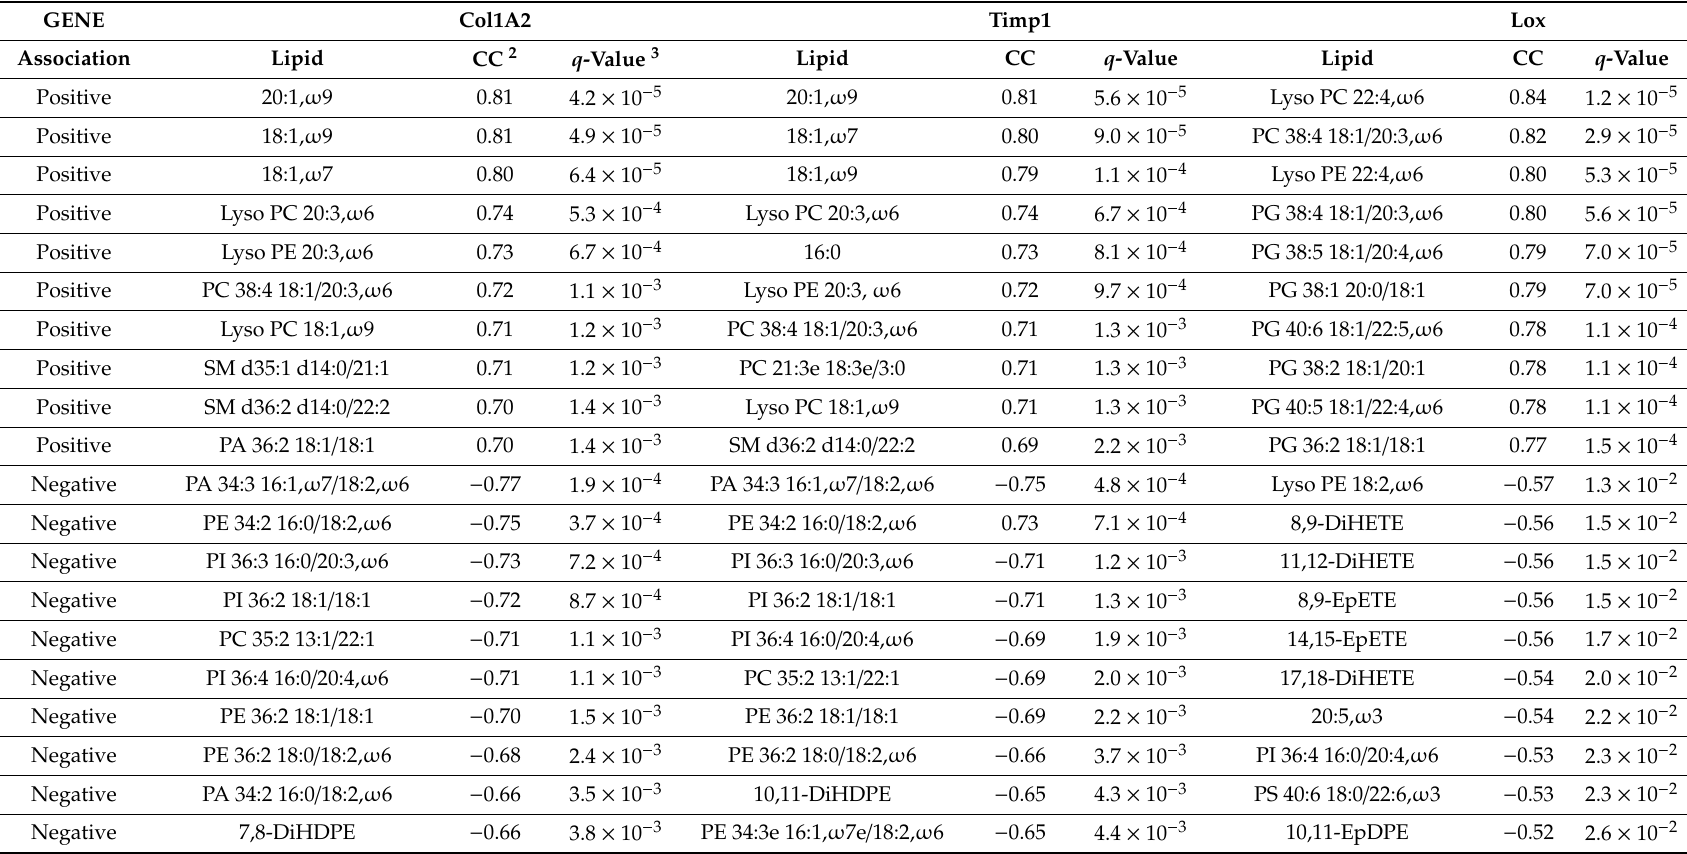
Table 2. Associations between hepatic gene expression markers of fibrosis and lipids 1